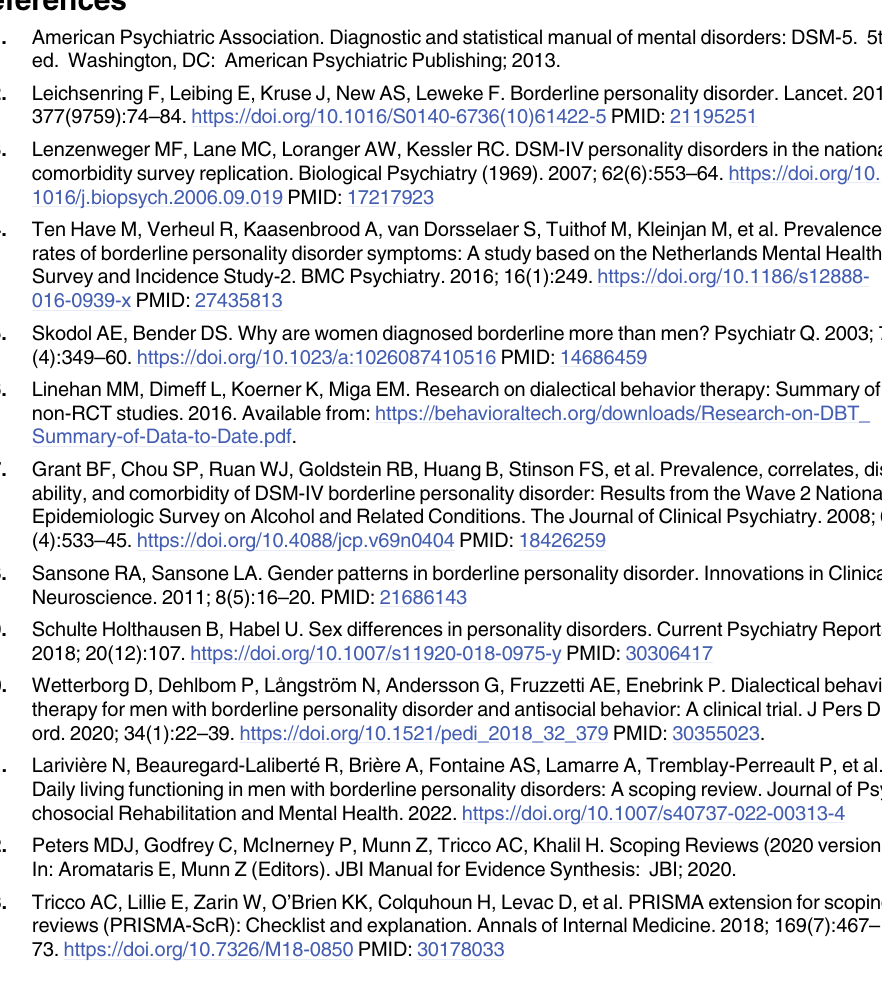
S1 Table. Data extraction form. S2 Table. Study characteristics